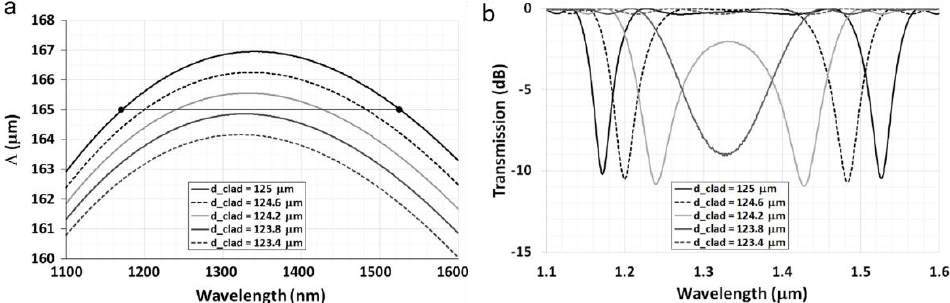
Figure 4. ( a ) PMC for LP 0,12 cladding mode as a function of the fiber diameter with a grating period of 165 mm (solid black line corresponds to the non-etched fiber, whereas solid dark gray line corresponds to the closest curve to the DTP condition). ( b ) Simulated spectra of LPFG with grating period of 165 µ m for decreasing thickness of the fiber diameter d clad from 125 µ m up to 123.4 µ m, detailing the evolution of the dual resonance bands up to DTP (solid dark grey line). Reprinted with permission from [42]. Copyright © 2014 Elsevier B.V.